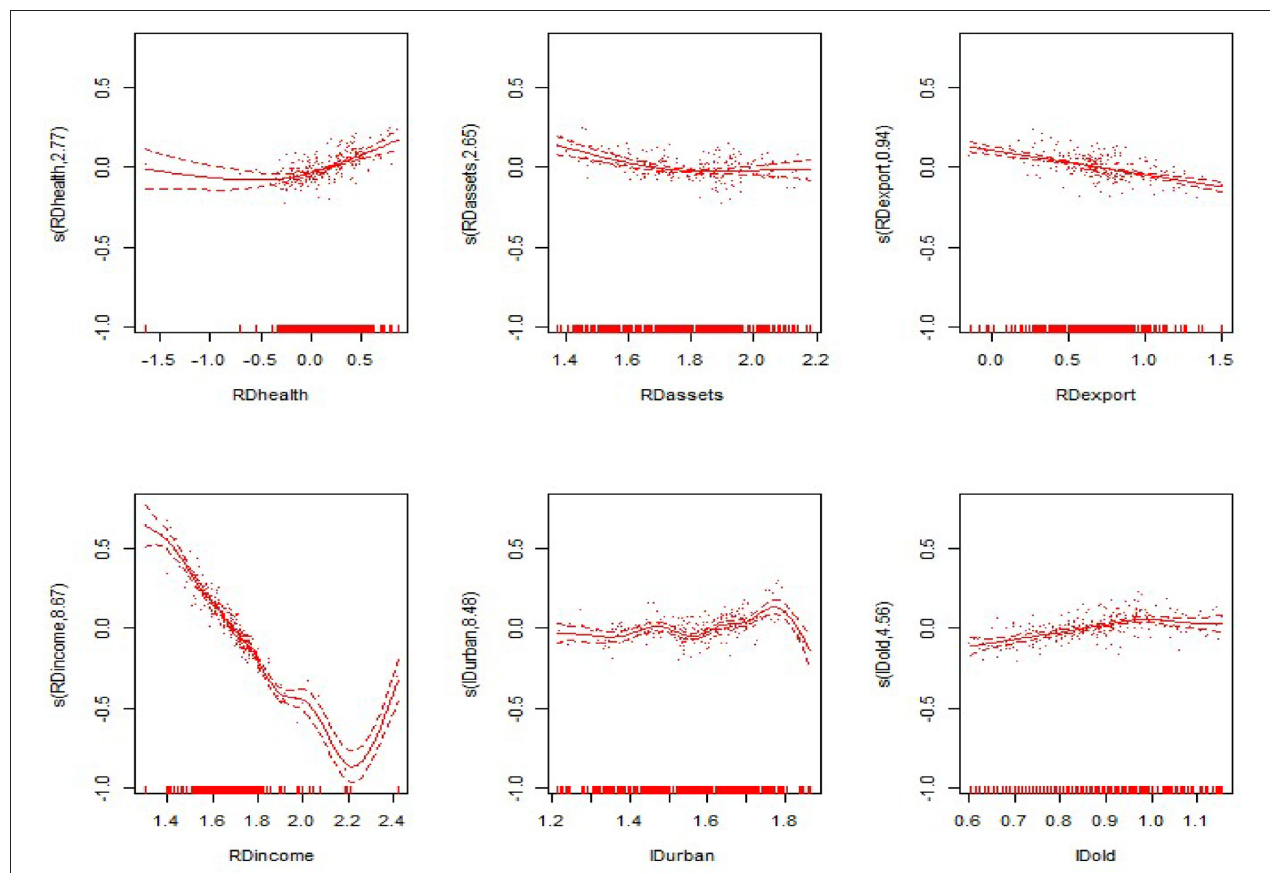
FIGURE 6 | Non-linear effects of the explanatory variables on per capita GDP in the western region.